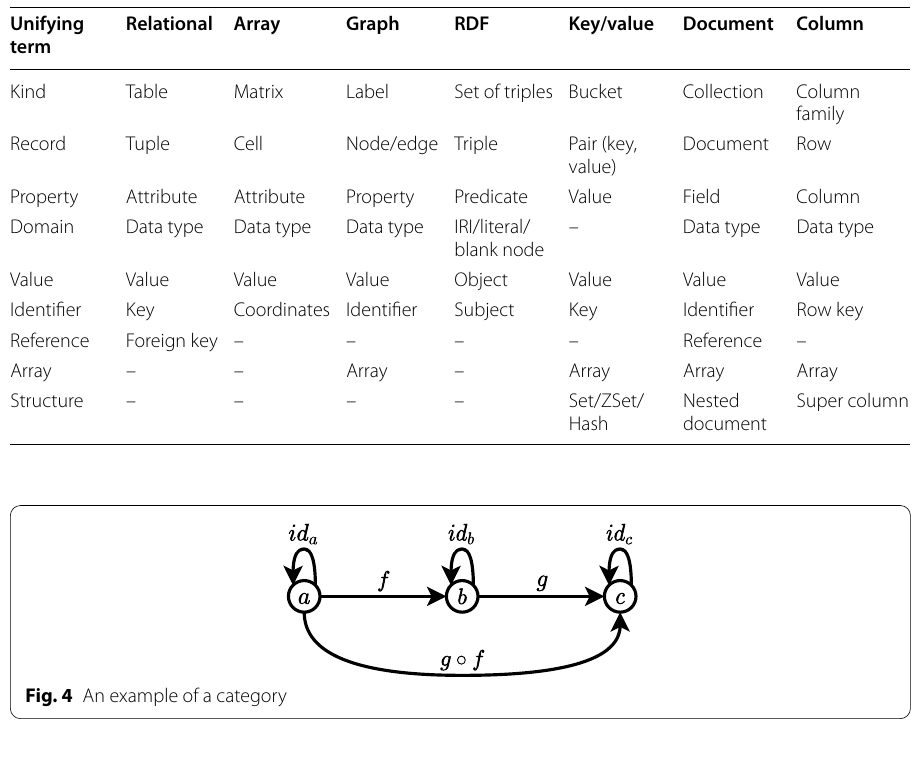
Table 1 Unification of terms in popular models Unifying term